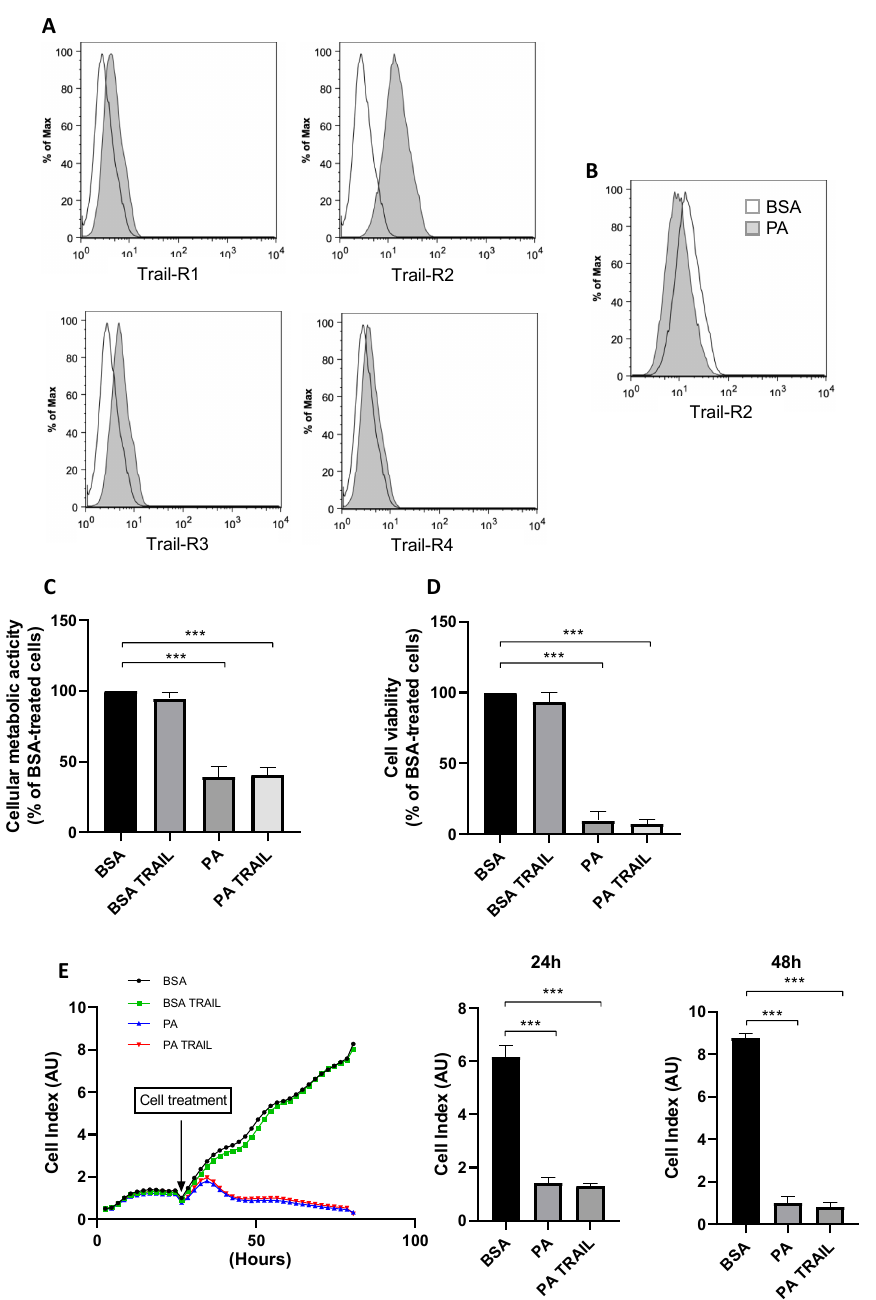
Figure 5. Surface expression of tumor necrosis factor (TNF)-related apoptosis-inducing ligand (TRAIL) receptors (Trail-R) and effect of TRAIL on palmitic acid (PA)-induced cytotoxicity. Representative expression of Trail-R at baseline ( A ) and after 48 h of treatment with Bovine serum albumin (BSA) or PA in ARPE-19 cells ( B ); cellular metabolic activity ( C ) and cell viability ( D ) after 48 h of treatment with BSA or PA in the presence or absence of TRAIL; cell density represented as time course or bar graphs ( E ) reporting ARPE-19 cell index after 24 and 48 h exposure to BSA or PA in the presence or absence TRAIL. Results are reported as mean ± SEM of at least three independent experiments. *** p 0.001.